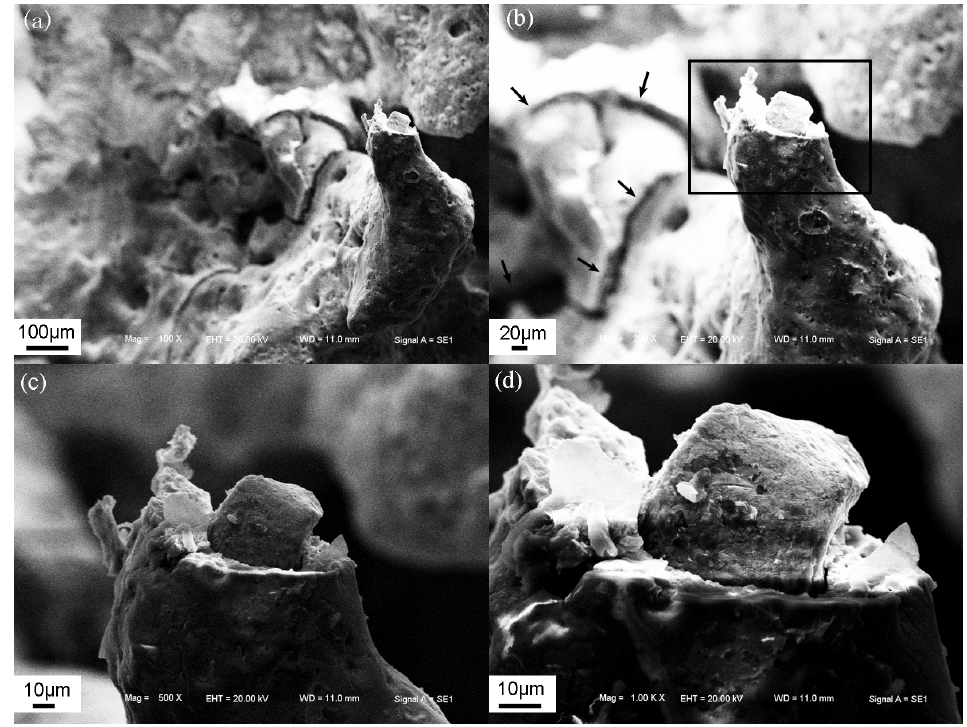
Figure 12. SEM image of the fracture of a foam strut: ( a ), and magnification ( b – d ) at room temperature.